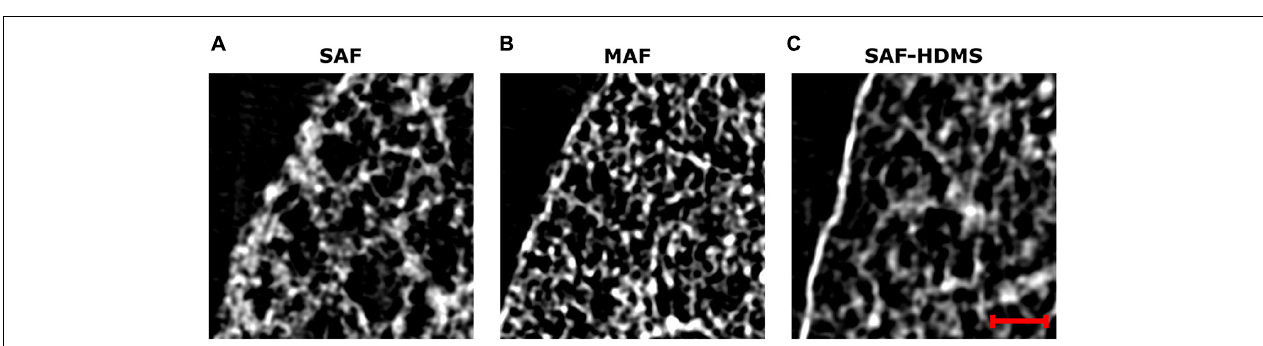
FIGURE 8 | Single-lung analysis of variability of alveolar surface density in different anatomical sections in Subject 1. Nomenclature: * p ≤ 0.05.